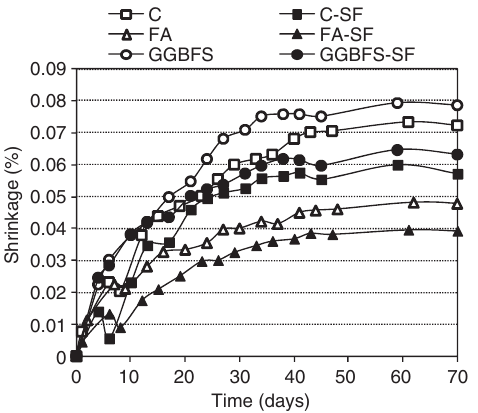
Figure 12 Drying shrinkage tendency.